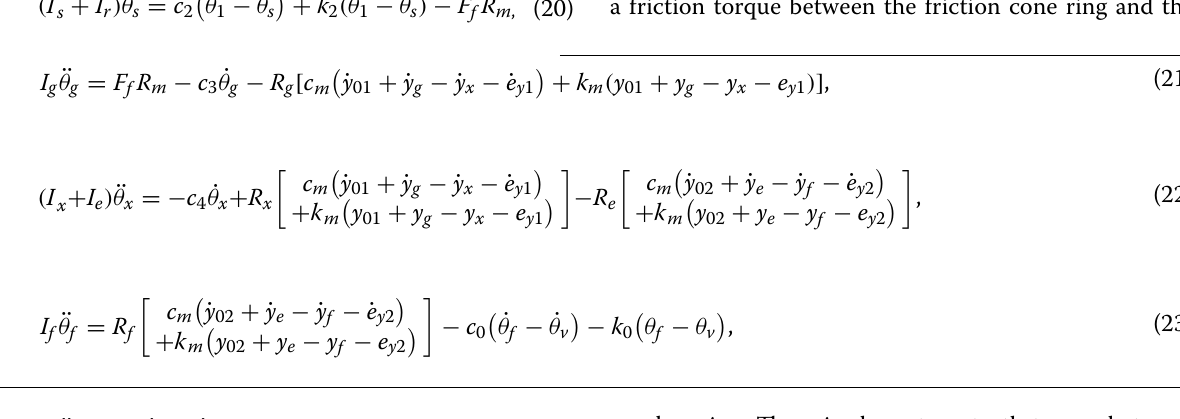
the sleeve can move again without completely eliminat- ing the speed difference. When the speed difference reaches the allowable range, the sleeve moves to contact the internal teeth of the friction cone ring to turn teeth, and the contact between the sleeve and the friction cone ring generates surface contact force. At this time, there is a friction torque between the friction cone ring and the